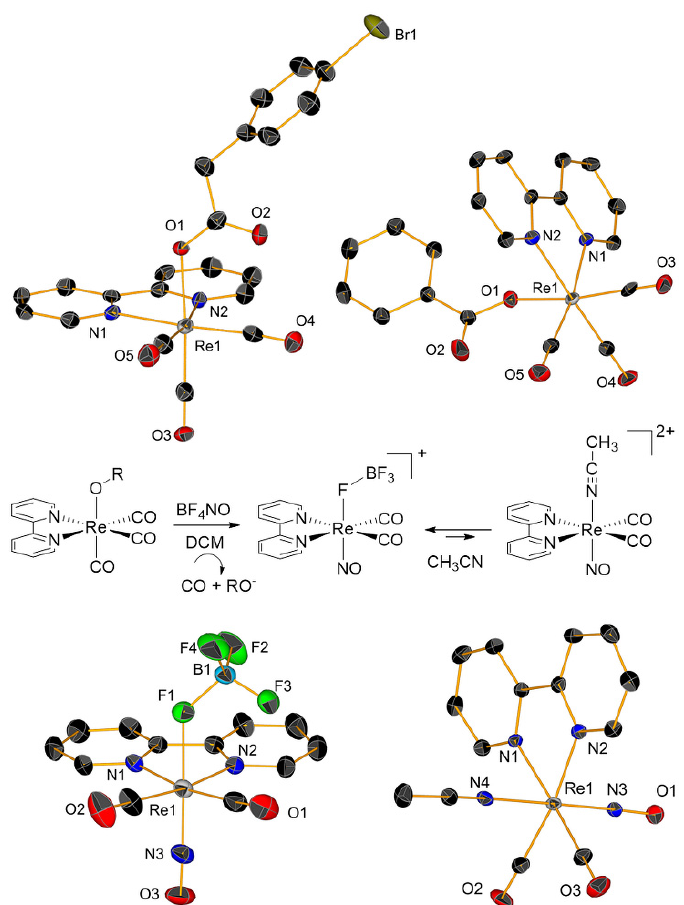
Figure 6. Top: crystal structures of carboxylato compounds 10 (left) and 11 . Middle: scheme of the reaction of fac -[Re I (CO) 3 (N-N)(OR)] (OR = OH − , benzoate, 2-(4-bromophenyl)acetate) with NOBF 4 . Bottom: crystal structures of 12 (left) and the fac -[Re(CO) 2 (NO)(N-N)(CH 3 CN)] 2+ ion ( 13 ). Thermal ellipsoids are at 30% probability. Selected bond lengths (Å) for 12 : Re-F1 2.082(4), Re-N1 2.137(6), Re-N2 2.132(5), Re-N3 1.794(7), Re-CO 1.999(9) and 1.985(9), C-O 1.123(10) and 1.125(10), N-O 1.139(8); for 13 : Re-N1 2.145(5), Re-N2 2.139(6), Re-N3 1.791(5), Re-N4 2.079(6), Re-CO 1.991(7) and 1.997(8), C-O 1.118(9) and 1.123(9), N-O 1.151(7). Selected bond angles (°): 12 , O3-N3-Re1 177.8(8); 13 , O1-N3-Re1 177.5(5).